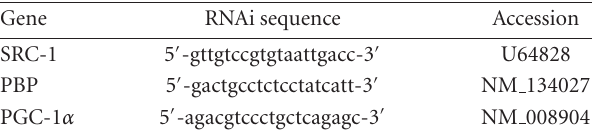
Table 1: Target sequences for coactivator RNAi. Gene RNAi sequence